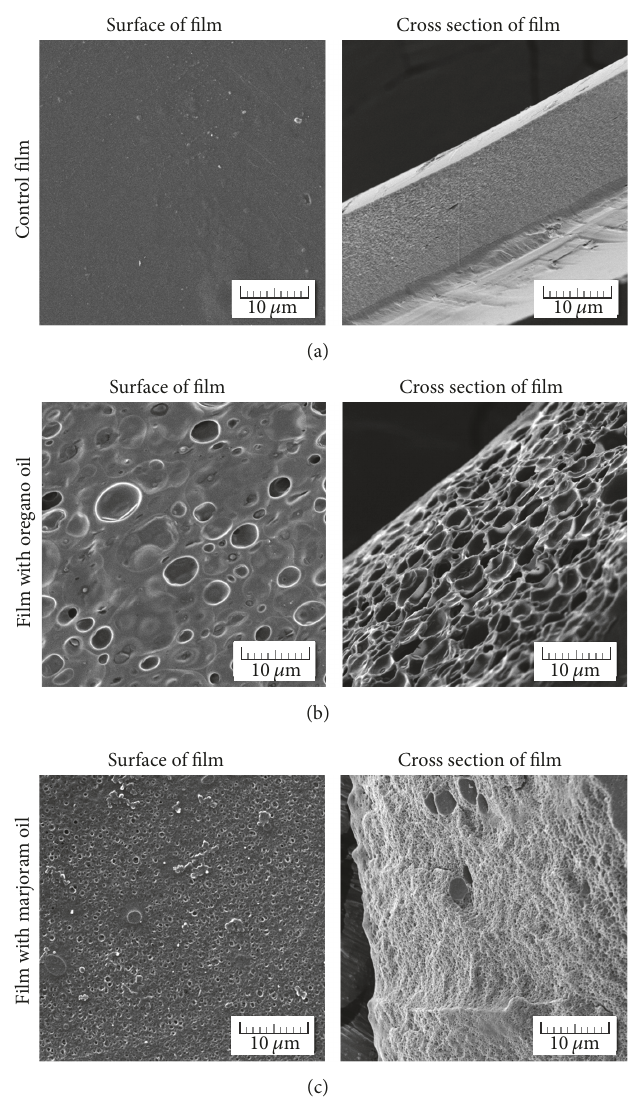
Figure 2: SEM micrographs of the surfaces (left) and cross sections (right) of chitosan films: (a) control, (b) with 3%wt. oregano oil, and (c) with 3% wt. marjoram